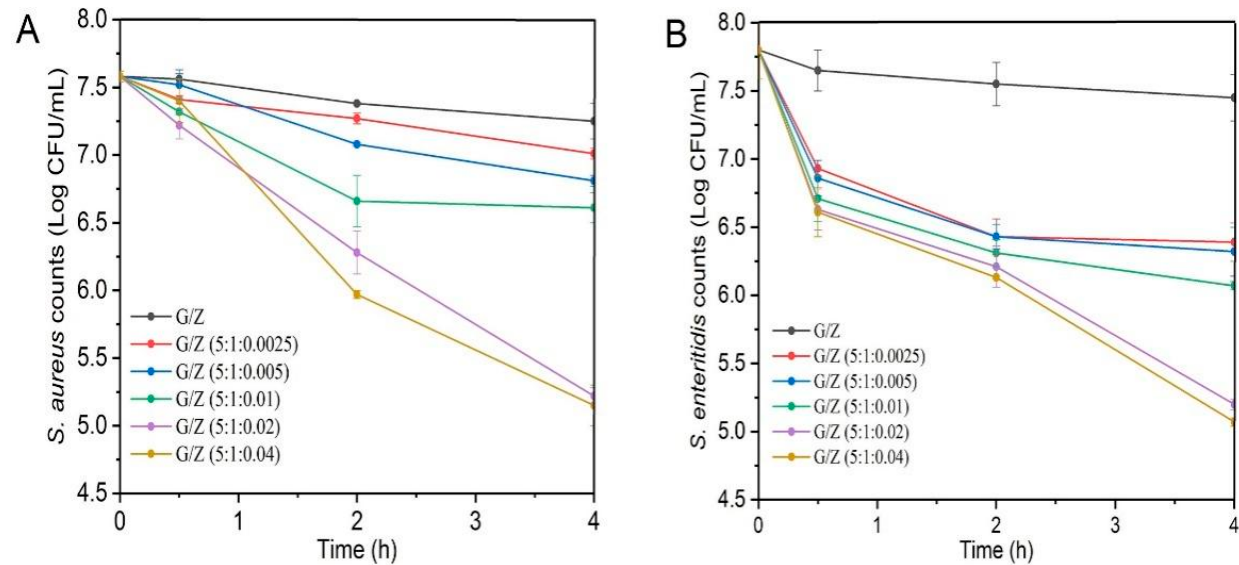
Figure 8. Inactivation of S. aureus and S. enteritidis by the gelatin/zein/perillaldehyde nanofiber films.